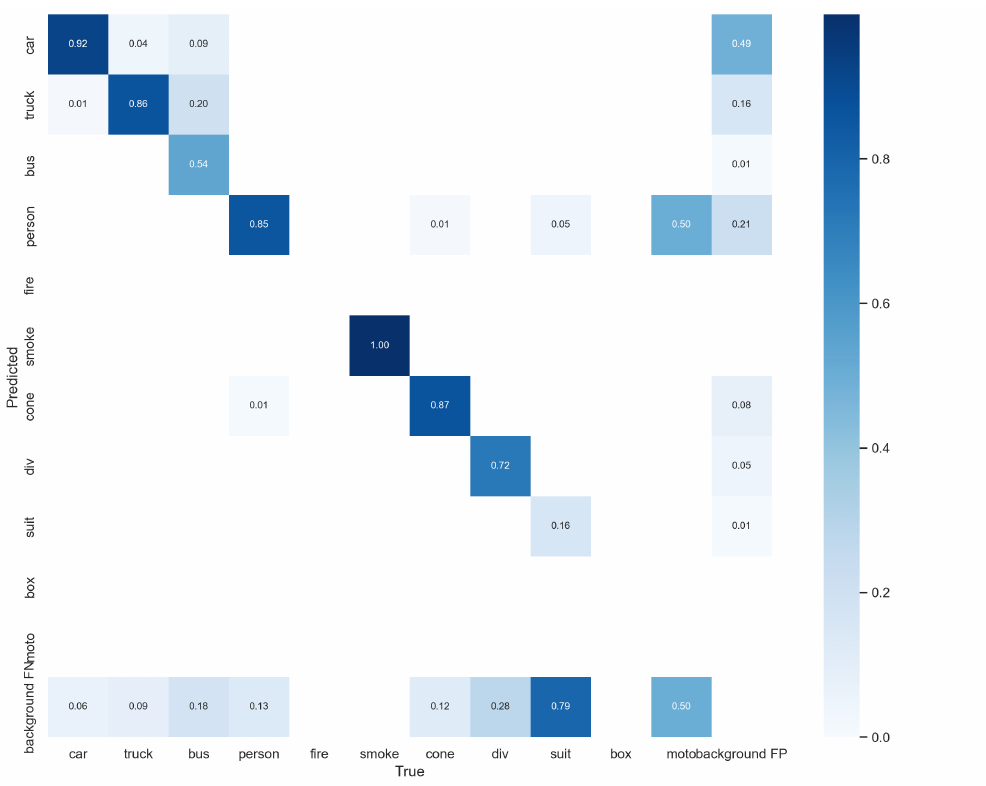
Figure 9. Confusion Matrix.